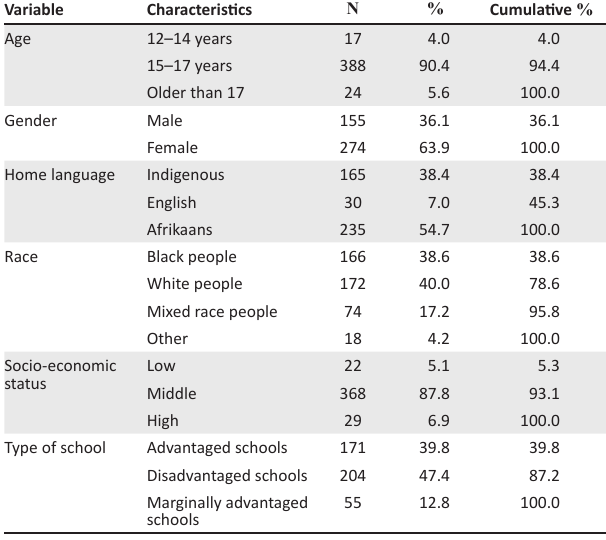
TABLE 1: Demographic profile of the sample.